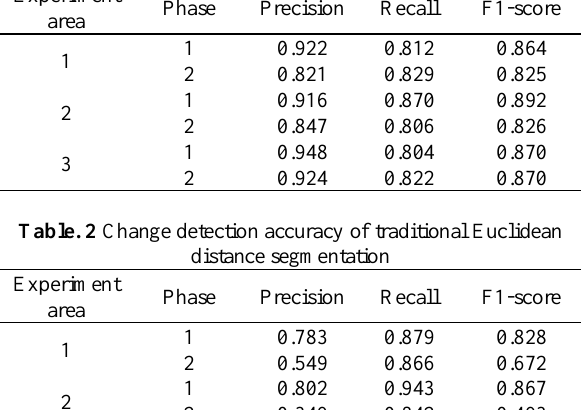
Table. 1 Change detection accuracy of the proposed method Experiment